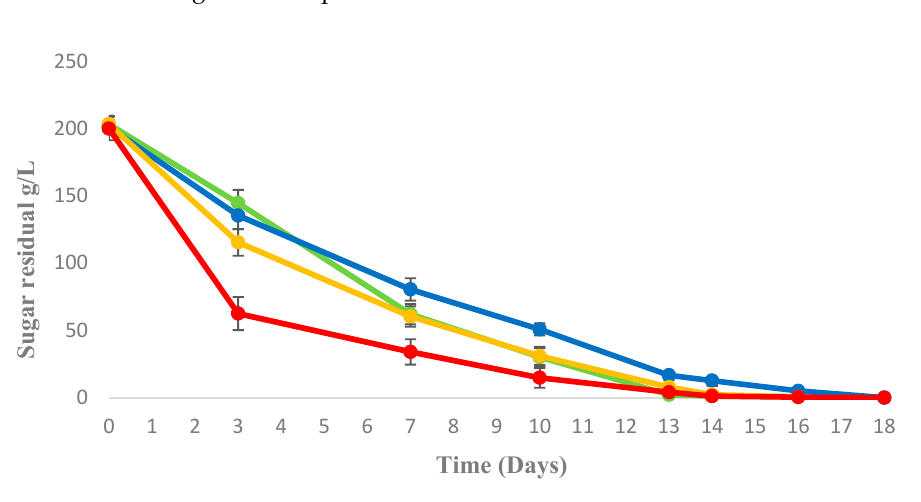
Time (Days) Time (Days) Time (Days) Figure 1. Sugar consumption in sequential fermentation trials of M. pulcherrima/S. cerevisiae: Figure 1. Sugar consumption in sequential fermentation trials of M. pulcherrima/S. cerevisiae: Figure 1. Sugar consumption in sequential fermentation trials of M. pulcherrima/S. cerevisiae: Figure 1. Sugar consumption in sequential fermentation trials of M. pulcherrima / S. cerevisiae: Figure 1. Sugar consumption in sequential fermentation trials of M. pulcherrima/S. cerevisiae: Figure 1. Sugar consumption in sequential fermentation trials of M. pulcherrima/S. cerevisiae: semianaerobic ( ); aeration 1 mL/L ( ); aeration 20 mL/L ( ); and S. cerevisiae pure semianaerobic ( ); aeration 1 mL/L ( ); aeration 20 mL/L ( ); and S. semianaerobic ( ); aeration 1 mL/L ( ); aeration 20 mL/L ( ); and S. semianaerobic ( ); aeration 1 mL/L ( ); aeration 20 mL/L ( ); and S. semianaerobic ( ); and S. cerevisiae semianaerobic ( ); aeration 1 mL/L ( ); aeration 20 mL/L ( ); and S. pure culture in semianaerobic ( culture in semianaerobic ( ). cerevisiae pure culture in semianaerobic ( ). cerevisiae pure culture in semianaerobic ( ). cerevisiae pure culture in semianaerobic ( ). cerevisiae pure culture in semianaerobic ( ).